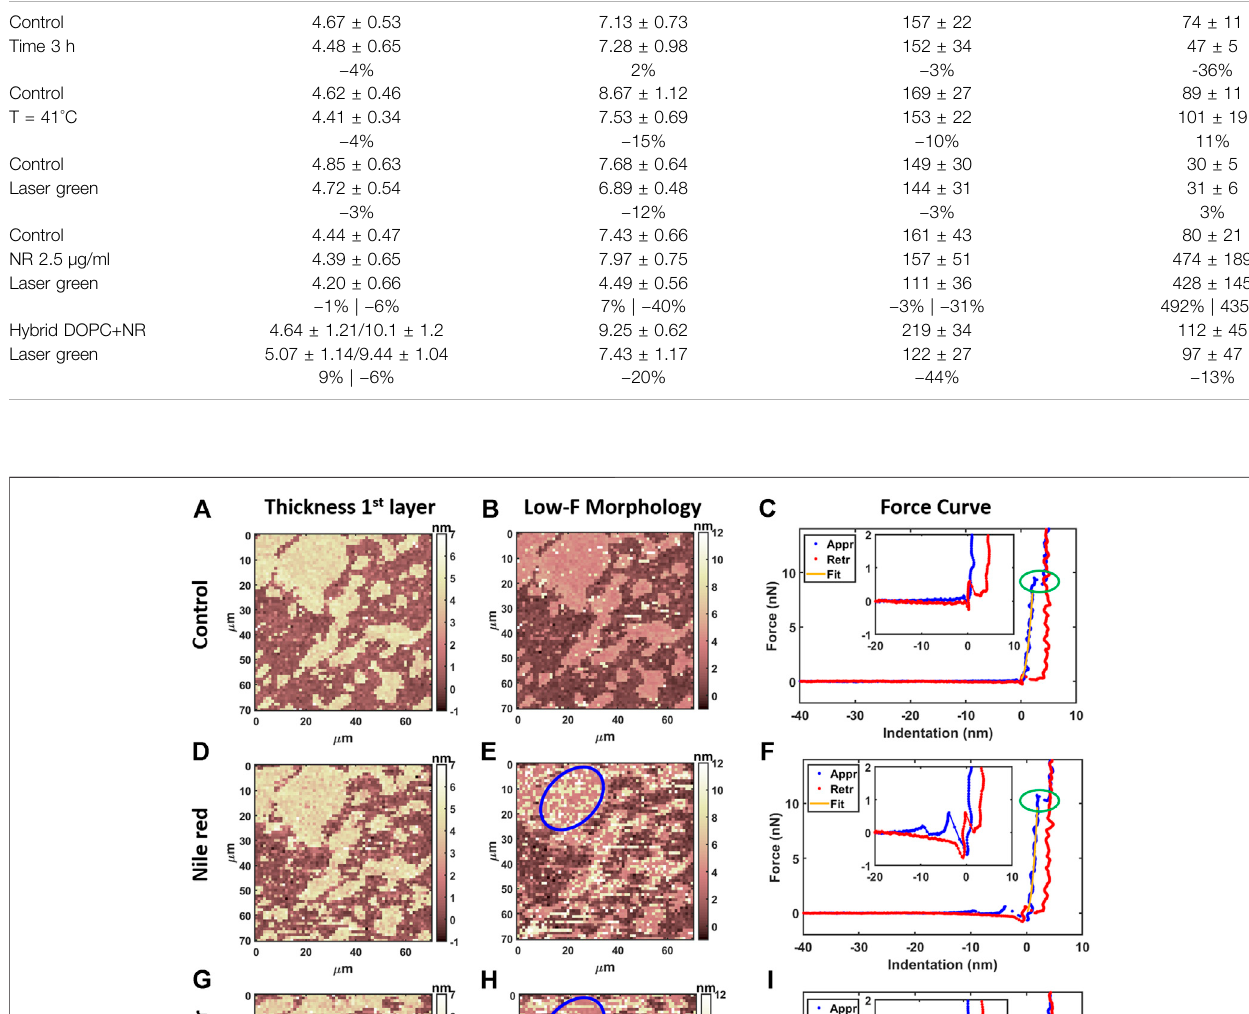
TABLE 1 | Summary ofexperimental setting parameters and obtained mechanical properties.For each experiment weshowthe percentual variability ofselected conditions in comparison with control.